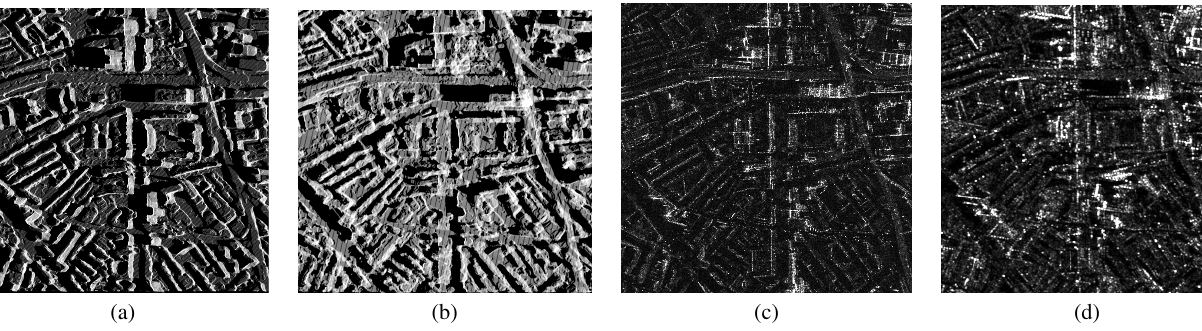
Figure 4. Residential buildings around Southwark in London. SAR image simulated using the preprocessed DSM (a, b); images c) and d): related TerraSAR-X images acquired in January 2010 and October 2015.